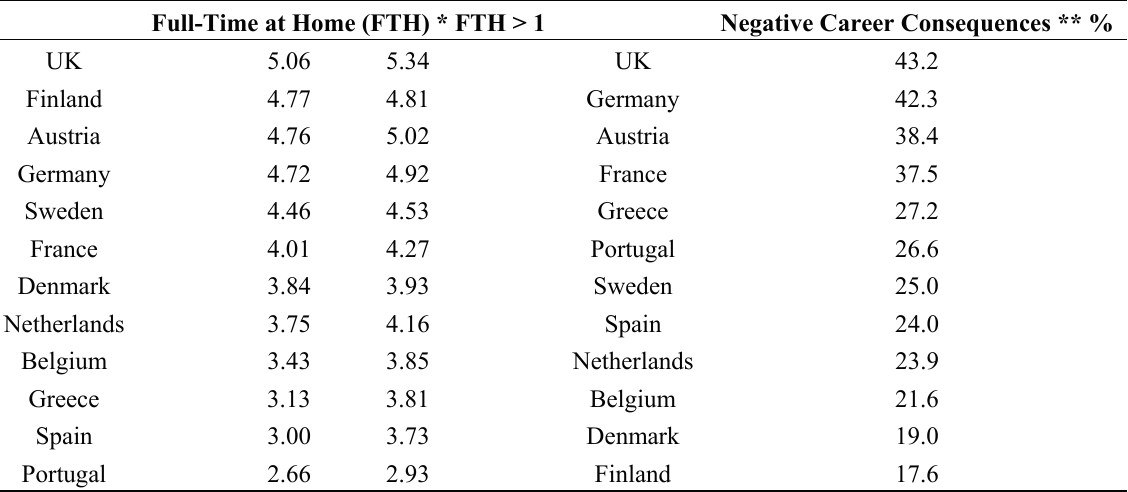
Table 3. Average time spent full-time at home due to childcare and subjectively assessed career